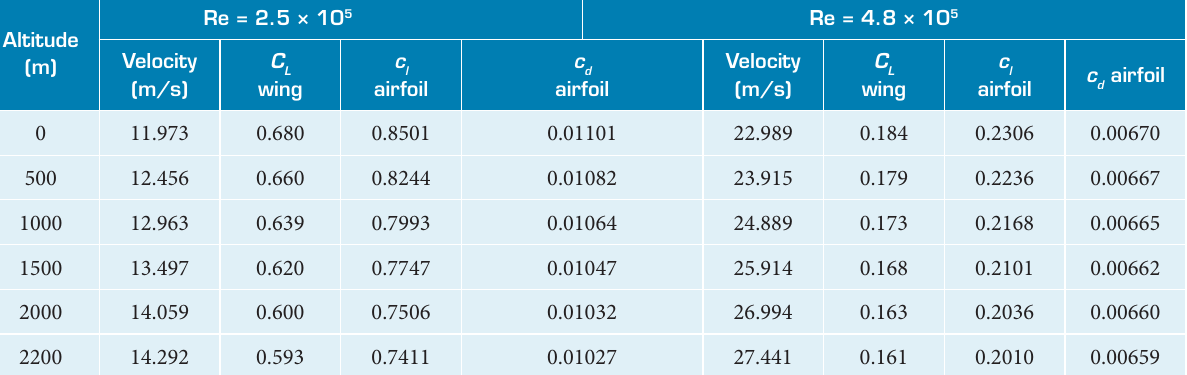
Table 8. Recalculated flight velocity for morphing SUAV.